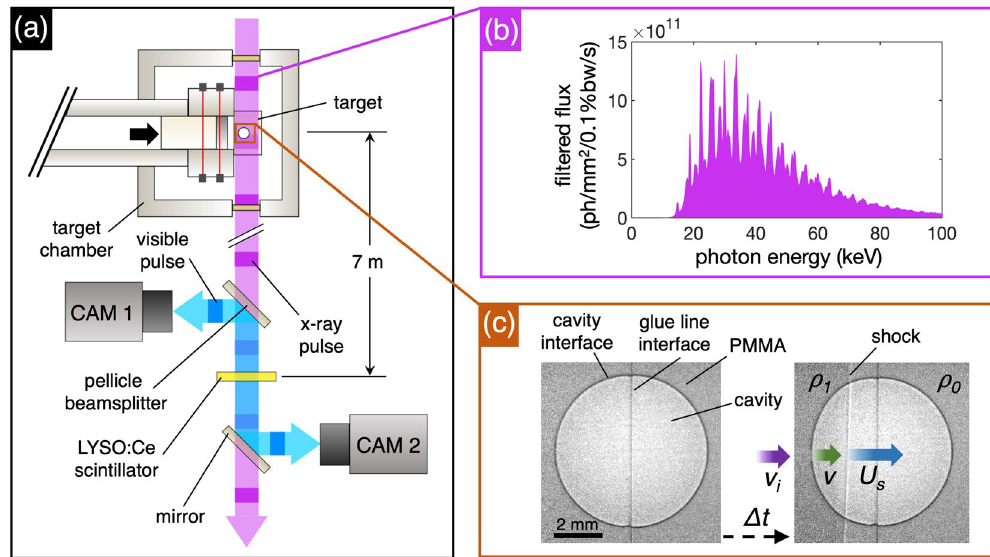
Figure 2. Illustration showing key features of the experiment. ( a ) Schematic diagram showing the imaging system, which is placed 7 m away from the target chamber. The X-ray pulses are absorbed by a LYSO:Ce scintillator after passing through the experiment, which re-emits visible photons. The front- and rear-surface scintillator emissions are folded away from the X-ray beam path by a mirror and pellicle beamsplitter, respectively, and are captured by two UHS cameras. ( b ) Model of the photon flux (ph/mm 2 /0.1%bw/s) with respect to photon energy (keV) of ESRF beamline ID19, calculated in XOP 66 . ( c ) Radiographs of a PMMA